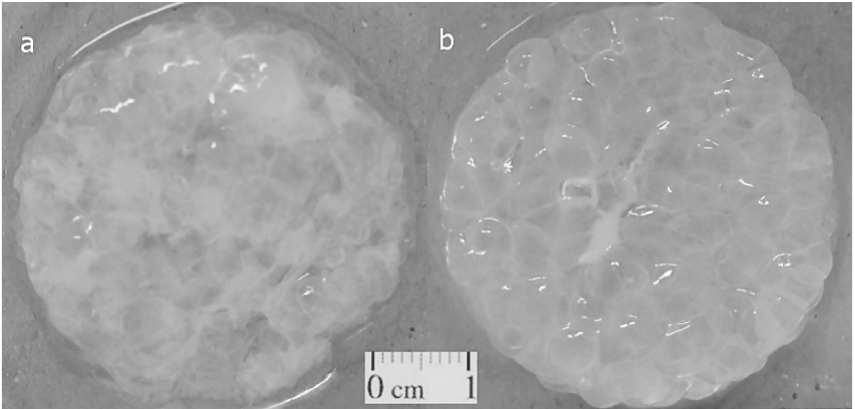
Figure 3: Sponges obtained by adding (a) CMC/CS at a ratio of 1 and (b) CS/CMC for a ratio of